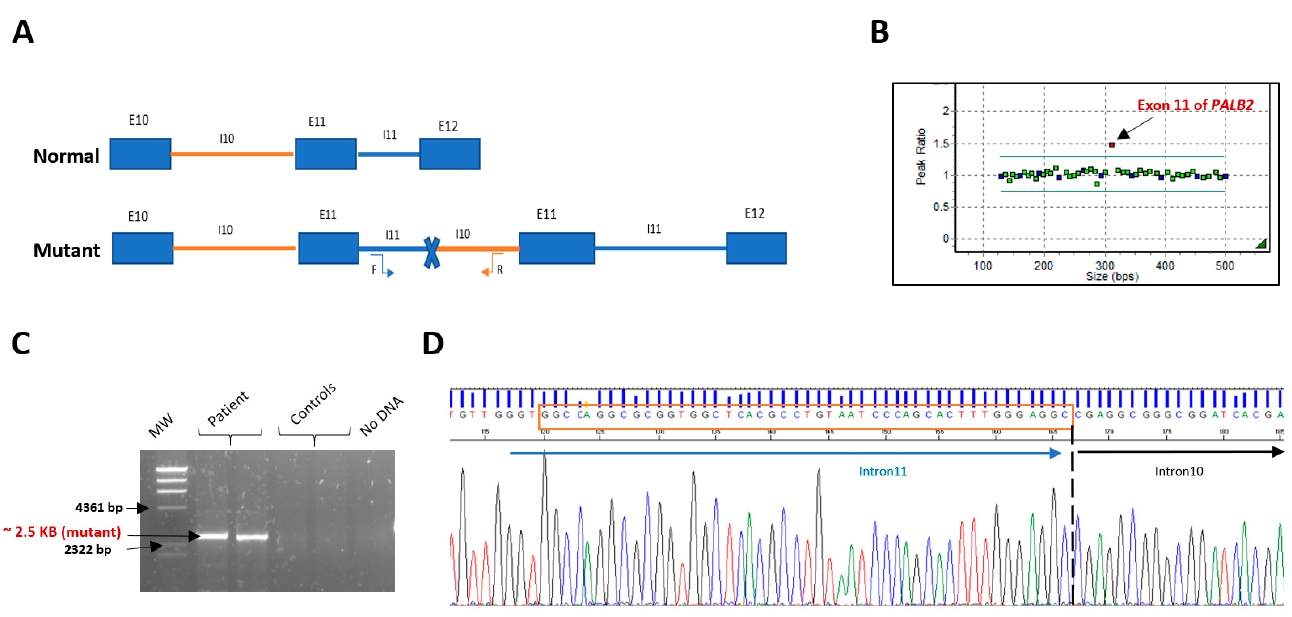
Figure 1. PALB2 Exon 11 duplication testing and breakpoint identification. ( A ) Schematic representation of the PALB2 normal and mutant alleles, with the duplicated region. The location and orientation of the primers used for specific duplication PCRs are indicated by vertical arrows. ( B ) PALB2 Exon 11 duplication confirmation by MLPA. ( C ) Long-range PCR. A specific band of approximately 2.5 kb was detected in the proband’s blood DNA, absent in control samples. ( D ) Electropherogram showing the breakpoint sequence (forward). Tandem duplication site (TDS) is boxed in orange.